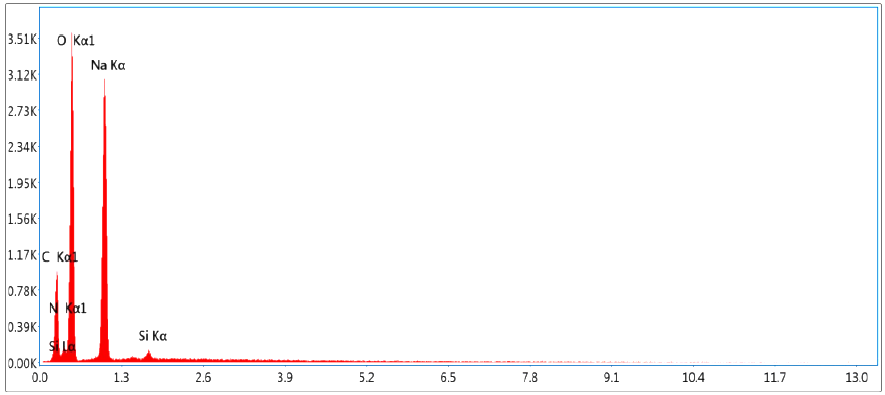
Figure 5. EDS spectroscopy of chemically extracted chitin. Table 1. Energy-dispersive X-ray spectroscopy of